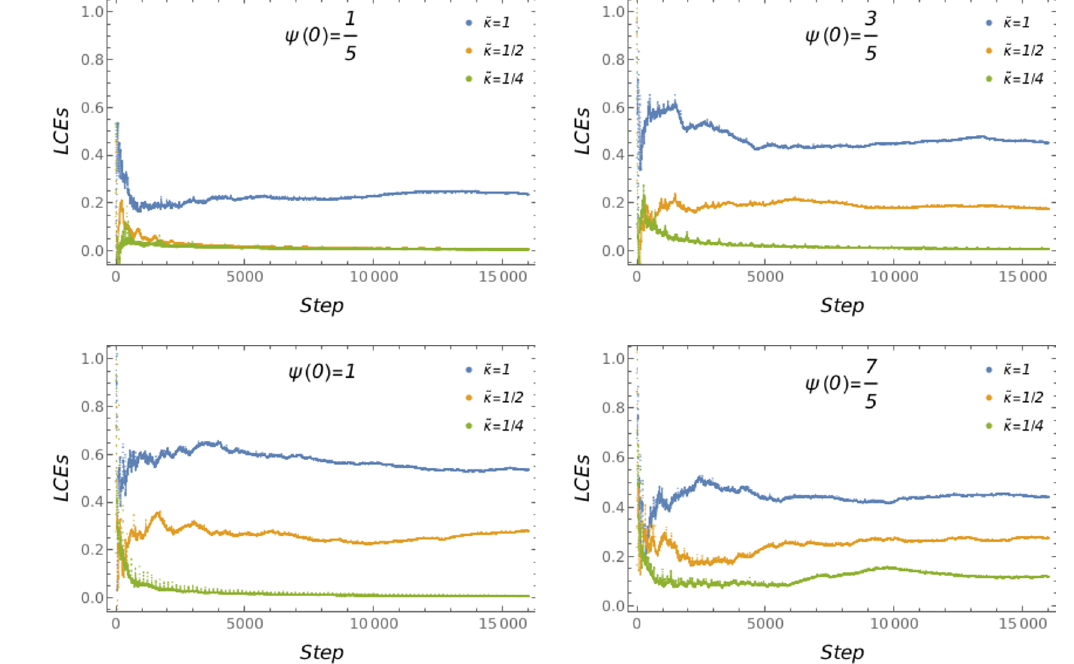
Figure 11 . Plot of the mLCE for the deformed SU (3) Landau-Lifshitz model. The initial conditions are p θ (0) = 3 / 10 , p ψ (0) = 11 / 10 , θ (0) = 1 and for different ψ (0) . The parameter values are α = w φ = w ϕ = 1 with ˜ κ varying. The total evolution time is T = 800 which is broken into 16000 iterative